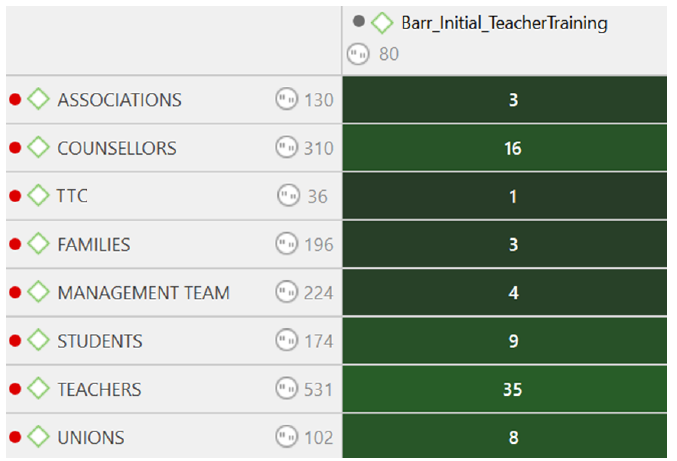
Figure 3. List of citations by group of participants: “Initial Teacher Training Barriers”. Source: Pre- pared by the authors.